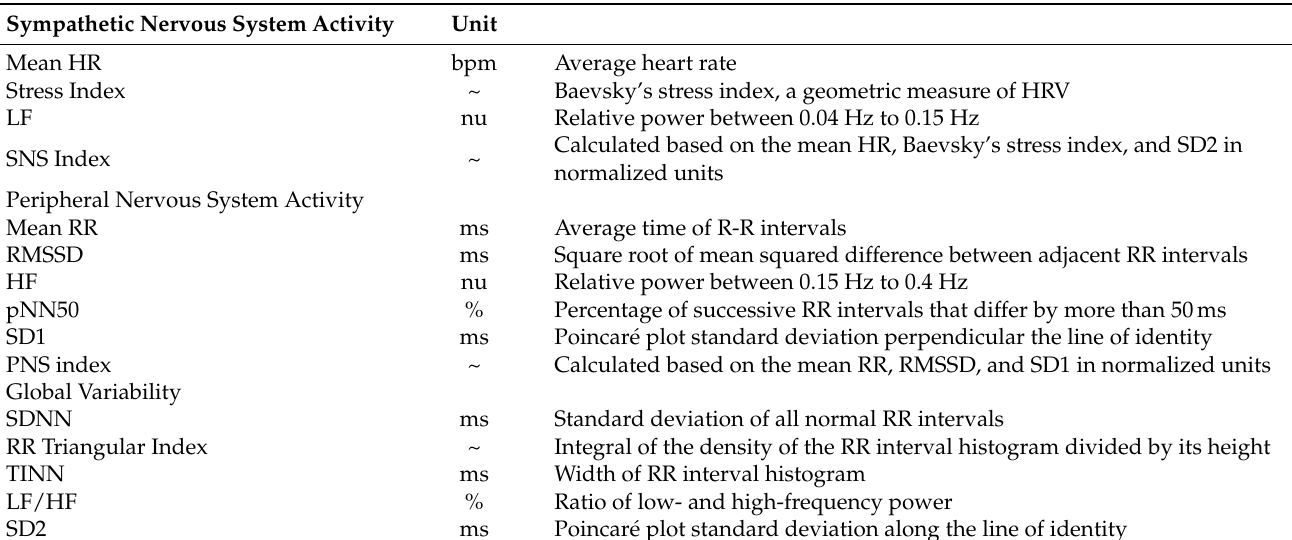
Table 1. Description of heart rate variability (HRV) indexes evaluated. Adapted from Shaffer F et al. [38]. Sympathetic Nervous System Activity Unit Average heart